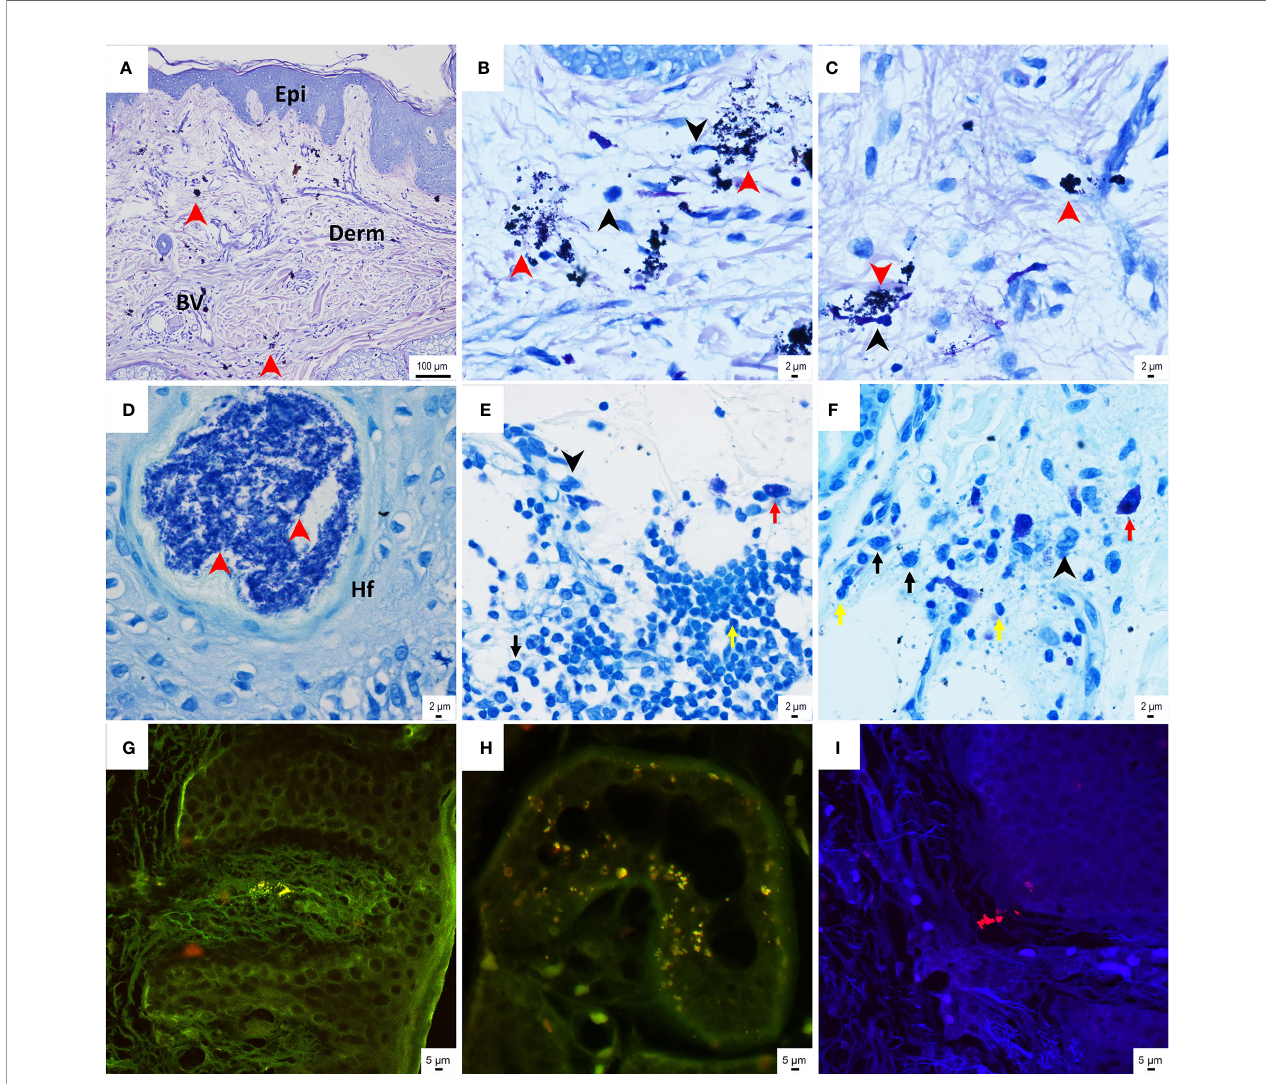
FIGURE 7 | Histological assessment of the skin sample above the BAHS implant. (A – C) Giemsa-stained histological sections show the normal appearance of skin structure, consisting of epidermis (Epi) and subepithelial connective tissue dermis (Derm) containing blood vessels (BV). Aggregates of bacterial cells (indicated by the red arrowheads in A – C ), as well as mononuclear/macrophage cells (indicated by the black arrowheads in B , D ), are frequently detected in the connective tissue. Some of the bacterial cells assume intracellular localization (B) . The toluidine blue-stained sections also show dense bacterial aggregates in association with hair follicles (red arrowheads in D ). (E, F) Relatively dense in fl ammatory in fi ltrates are found in the deepest part of the soft tissue sample, presumably interfacing with the bone where the implant is inserted. The in fl ammatory in fi ltrates in (E , F) consist of mononuclear cells/macrophages, lymphocytes, plasma cells, and mast cells (indicated by black arrowheads and the yellow, black, and red arrows, respectively). (G – I) Tissue sections underwent fl uorescence in situ hybridization (FISH) with a peptide nucleic acid (PNA) probe targeting coagulase-negative staphylococci (CoNS) and Staphylococcus aureus in the tissue. CoNS (red cocci of approximately 1 m m) were detected in the tissue, both super fi cially at the epidermis (G) and at deeper layers of the dermis (H, I) . Staphylococcus aureus (green cocci of approximately 1 m m) was also detected in the tissue (G, H)